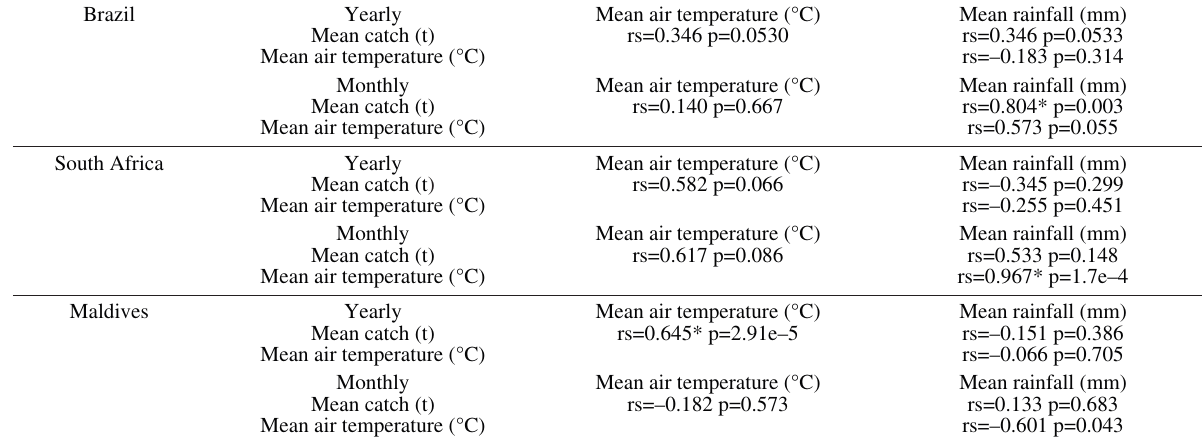
Table 1. – Spearman correlation coefficient calculated between both yearly and monthly average catch (t), air temperature (°C) and rainfall (mm), in the three studied area. The asterisk indicates significant correlation.